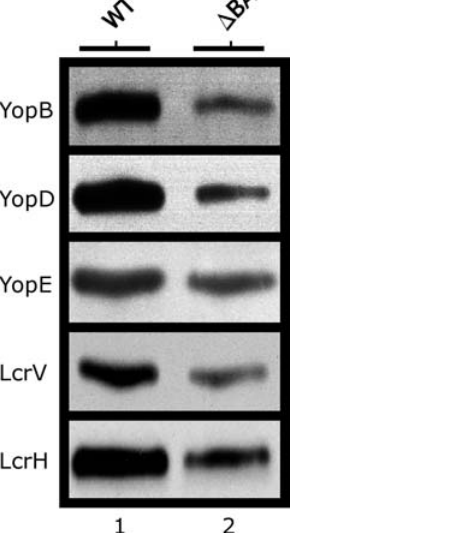
Figure 7. The D BA Mutant Strain Has Reduced Endogenous Levels of Effector Proteins Cultures of wild-type (WT) or D BA strains of Y. pseudotuberculosis were grown in low-calcium medium at 37 8 C for 3.5 h. Bacteria were harvested and analyzed for endogenous levels of YopB, YopD, LcrV, LcrH, and YopE proteins by Western blot analysis using Yop-specific polyclonal anti- bodies. DOI: 10.1371/journal.ppat.0020006.g007